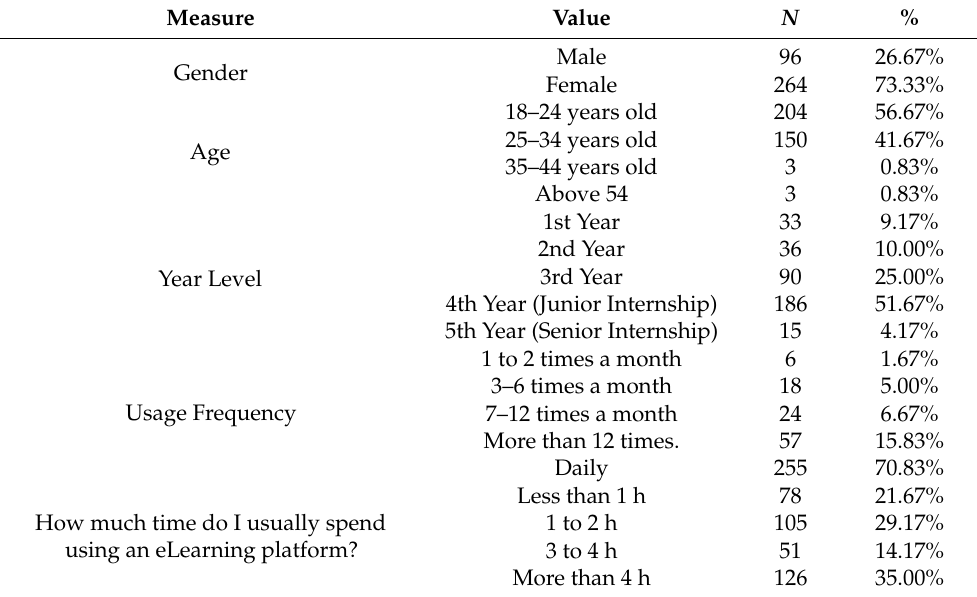
Table 1. Descriptive statistics of the respondents ( N =